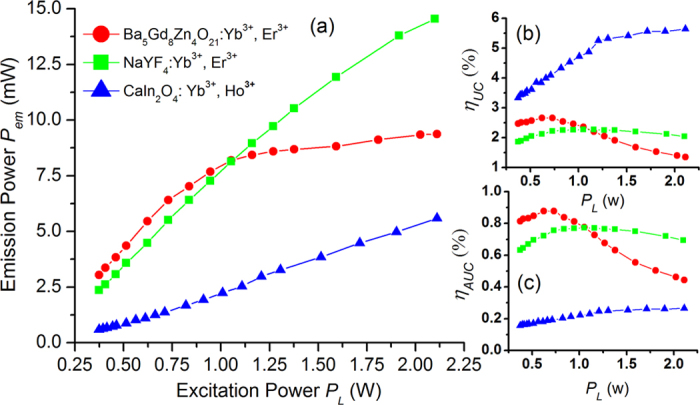
Comparison among three types of UC materials.The comparison of (a) emission power, (b) UC power efficiency and (c) actual UC power efficiency among three types of UL materials: Ba5Gd8Zn4O21:15% Yb3+, 5% Er3+ (red line), CaIn2O4:10% Yb3+, 0.5% Ho3+ (green line) and β-NaYF4:18% Yb3+, 2% Er3+ (blue line). The excitation source is a 971 nm power-controllable diode laser.